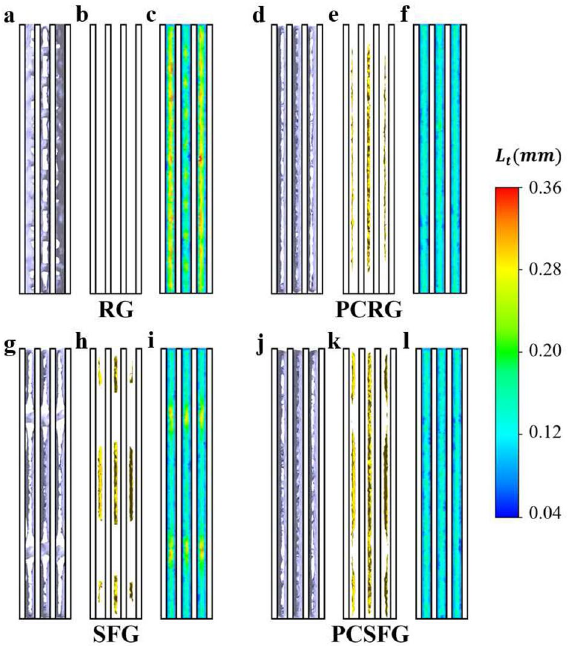
Figure 7. The cross-sectional isosurface representation of ( a , d , g , j ) U/U 0 = 2.38, ( b , e , h , k ) I = 0.33; and ( c , f , i , l ) the 2D contour plot of L t induced from various grid at x / D h = 0.125. Note that δ = 5 mm and l / D h =